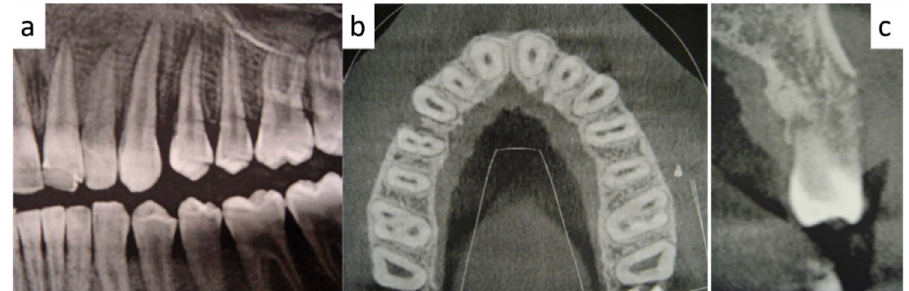
Figure 2. ( a ) Panoramic radiogram showing an irregular radiolucency between the dental roots of 2.3 and 2.4 teeth, with periodontal enlargement; on CT scans, vestibular cortical erosion ( b ) and irregular and margins were detected( c ).